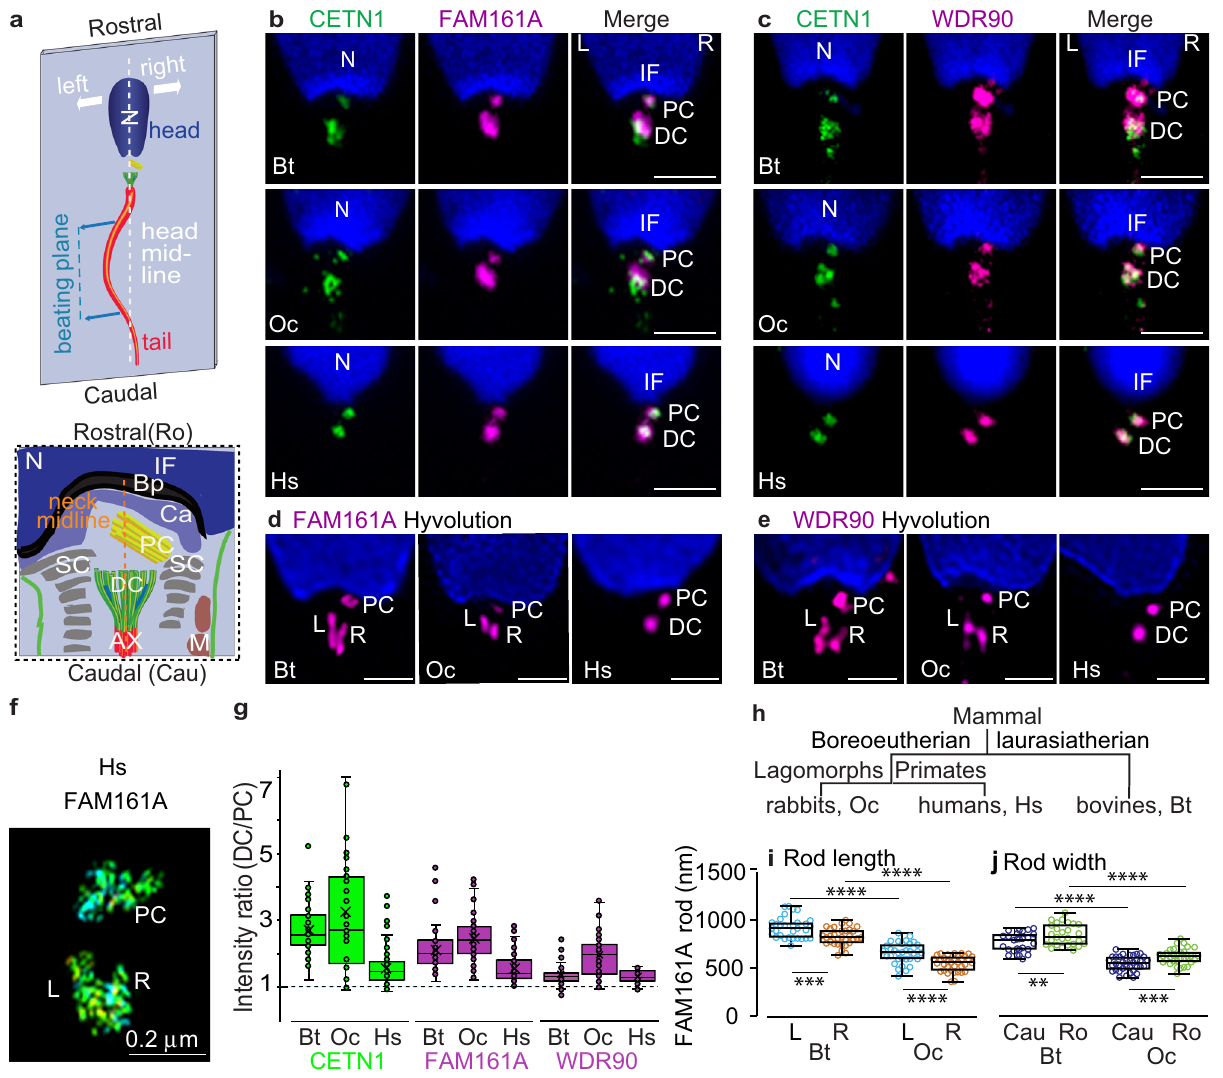
Fig. 1 FAM161A and WDR90 are proteins in the atypical distal centriole. a Schematics illustrating the sperm cell (top) and neck asymmetry (bottom). The head and neck asymmetry provide a basis for orientation in all fi gures, such that the top is rostral, the left side is on the left. Throughout the paper, images are oriented such that PC is at the right side of the connecting piece, and the distal tip of the PC points to the right side. Note that sperm beating occurs in one plane. b , c Confocal imaging with FAM161A ( b ) and WDR90 ( c ) staining. Both proteins partially co-localize with CETN1 at the PC and DC in sperm of bovines ( Bos taurus , Bt), rabbits ( Oryctolagus cuniculus , Oc), and humans ( Homo sapiens , Hs). Scale bars 2 μ m. d , e HyVolution imaging in bovine, rabbit, and human sperm with FAM161A ( d ) and WDR90 ( e ) staining. Scale bars 1 μ m. f 3D-STORM imaging of human sperm with FAM161A staining. Note: STORM re fl ects labeling distribution, not intensity. g CETN1, FAM161A, and WDR90 intensity measurement from confocal images at DC and PC of bovine ( n = 66 for CETN1 and FAM161A, n = 39 for WDR90), rabbit ( n = 37 for CETN1, n = 80 for FAM161A, n = 46 for WDR90), and human ( n = 62 for CETN1, n = 75 for FAM161A, n = 36 for WDR90) sperm. h Bovines (Laurasiatherian), humans (Boreoeutherian; Primates), and rabbits (Boreoeutherian; lagomorphs) represent three major phylogenetic groups of mammals. i , j FAM161A rod length ( i ) and width ( j ) measurement in bovines ( n = 31 for length, n = 26 for width) and rabbits ( n = 34 for length, n = 35 for width) based on confocal HyVolution imaging. Data are presented as box and whisker plots, where upper and lower bounds show interquartile range, line within the box shows median, and whiskers show minimum and maximum data points. Throughout the paper, the labels are the same: N nucleus, IF implantation fossa, PC proximal centriole, DC distal centriole, Bp basal plate, Ca capitulum, SC segmented column, Ax axoneme, M mitochondria, L left side, R right side, Cau caudal, Ro rostral. Statistical analysis, unpaired, two-tailed t test. **P < 0.01, ***P < 0.001, ****P < 0.0001; ns not signi fi cant. Source data are provided as Source Data File. (Fig. 2f, g). The bars are asymmetric and are made of 1 – 4 plates of plates and is longer than the left (Supplementary Fig. 2d). The varying sizes separated by electron-lucent inter-plate material, two bars are also situated closer to the DC ’ s right microtubules revealing an unexpected level of complexity (Fig. 2g). Unlike the (Fig. 2f and Supplementary Fig. 2d). We observe electron density rods ’ “ V ” shape, the bars are nearly parallel to each other associated with the lateral doublet microtubules ’ inner surface (Supplementary Fig. 2b). The caudal edge-to-edge gap between that corresponds to the rods ’ estimated location (Fig. 2f and the smallest DC rods (POC5) is much larger (43%) than the Supplementary Fig. 2e). Altogether, these differences suggest that corresponding gap between the bars (Supplementary Fig. 2c). The the central bars scaffold the central pair, while the rods scaffold rods and bars have opposite asymmetry: the right bar has more the DC lateral side microtubules (Fig. 2e). NATURE COMMUNICATIONS| (2021) 12:3808